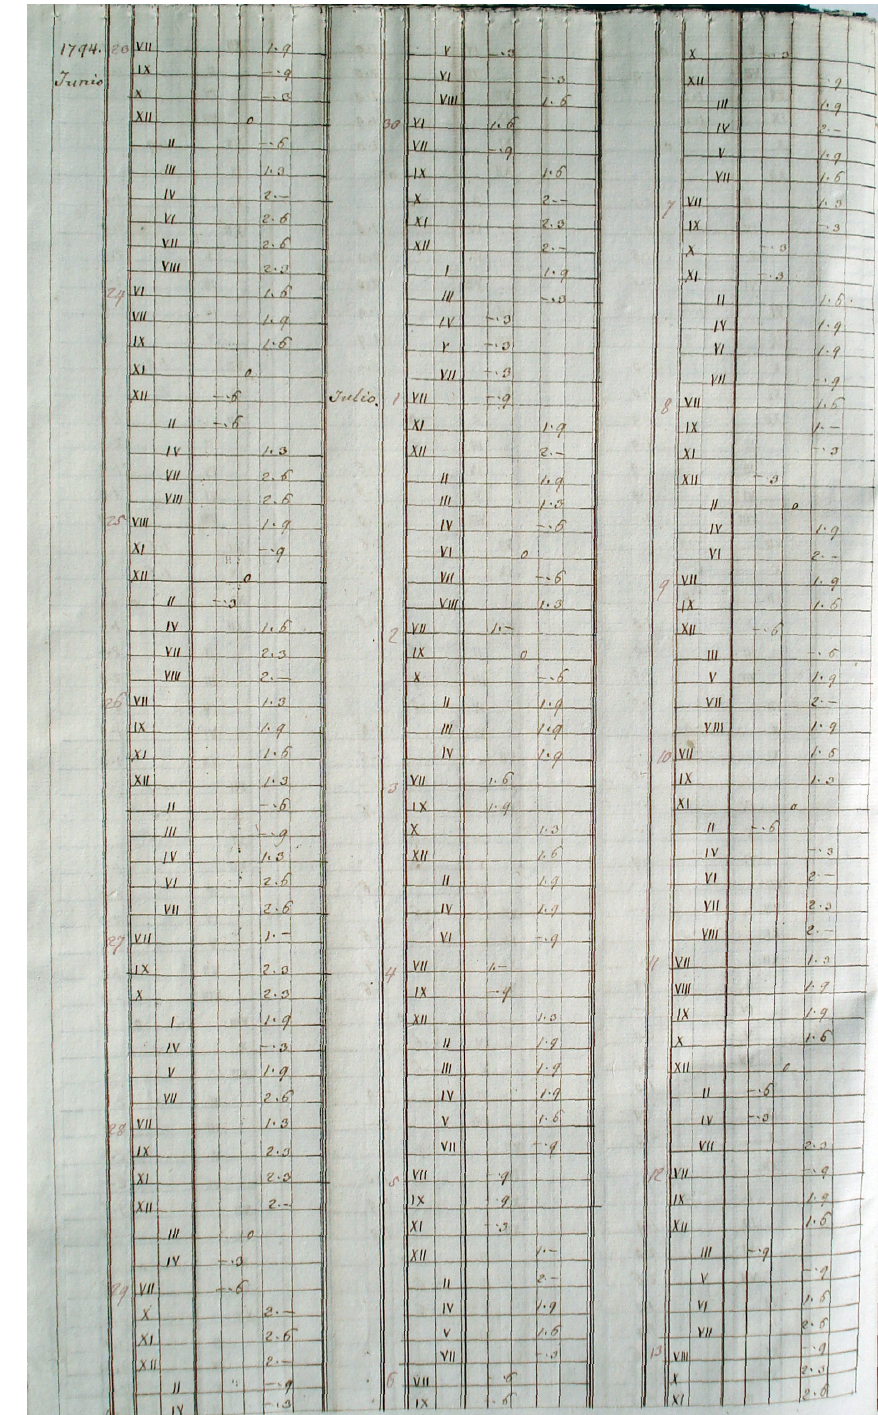
Figure 3. Manuscript page from 20 June to 13 July 1794 (courtesy of the Ancient Archive of the National Institute for Astrophysics Astronomical Observatory, Padua, Italy;